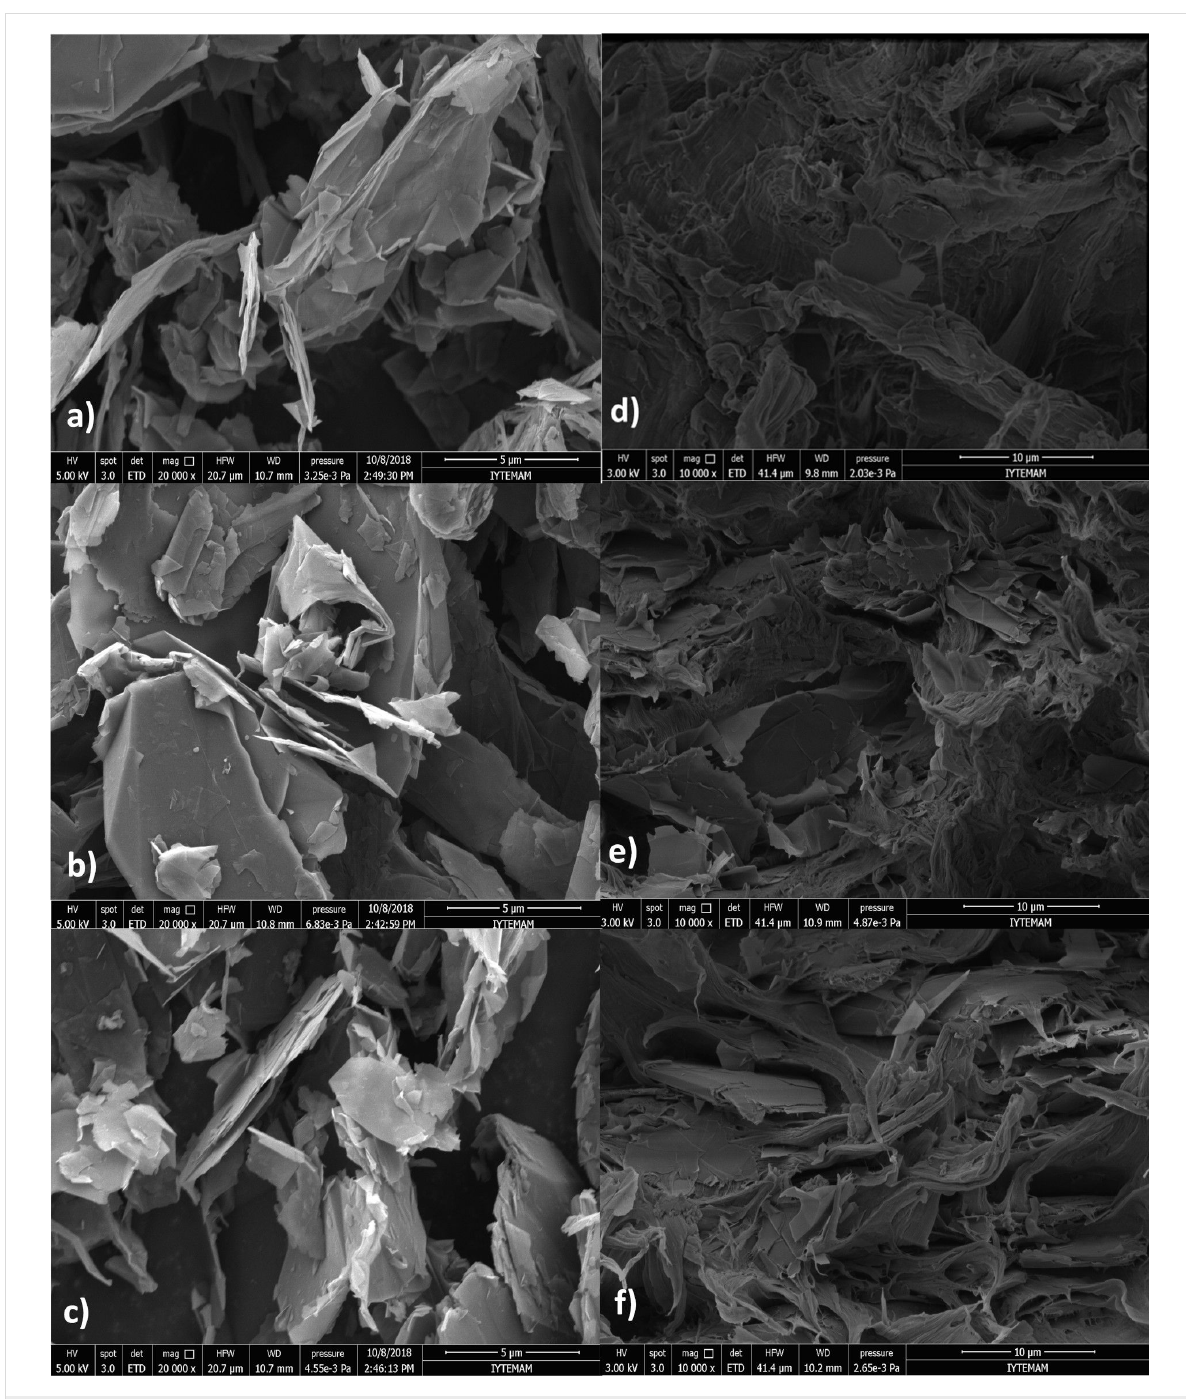
Figure 1: SEM images of a) G1, b) G2, c) G3, d) HDPE/G1 nanocomposite with 5.52 vol %, e) HDPE/G2 nanocomposite with 5.52 vol %, and f) HDPE/G3 nanocomposite with 5.52 vol %.